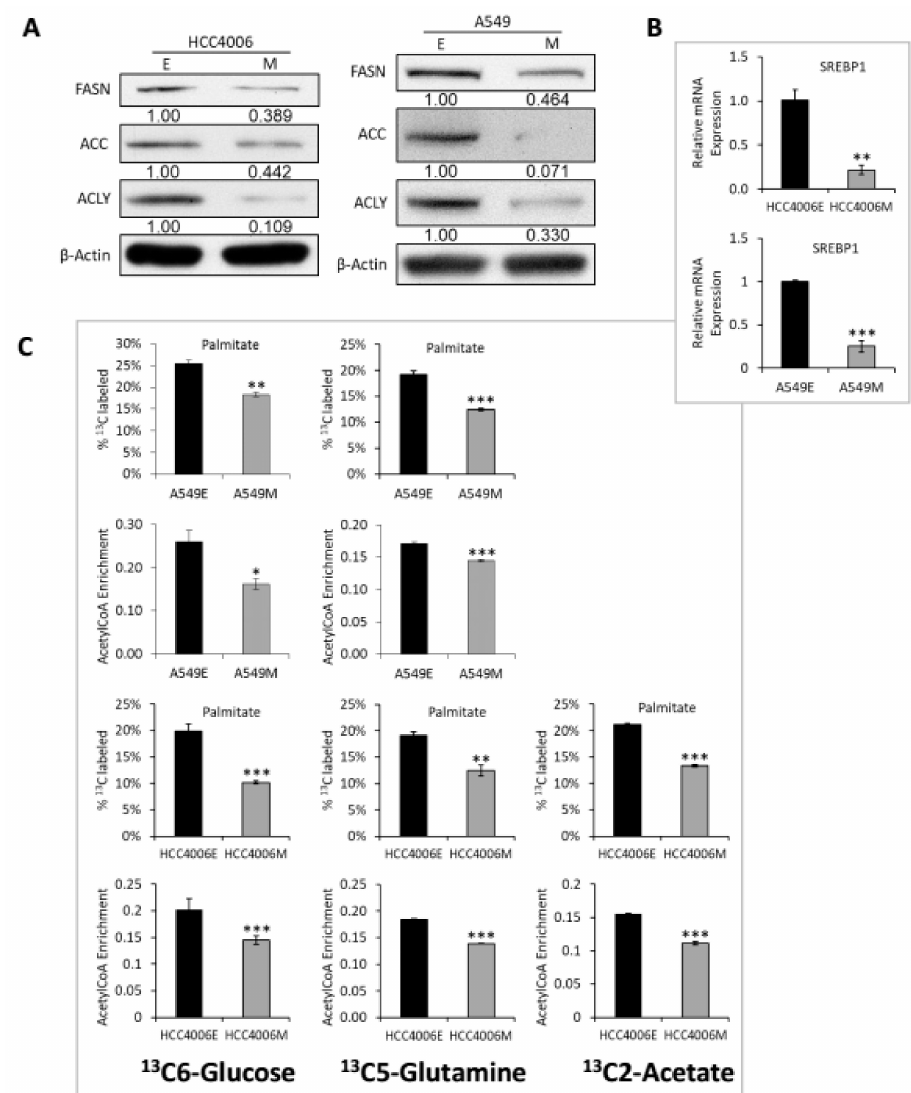
Figure 3. De novo lipid synthesis is decreased in isogenic mesenchymal cell states. ( A ) In HCC4006 and A549 cells, lipogenic enzymes decrease in the M state by immunoblot. ( B ) SREBP1 / SREBF1 RNA is reduced in the M state ( p < 0.05 *; p < 0.01 **; p < 0.001 ***). ( C ) A549 and HCC4006 have decreased incorporation of 13C6-glucose, 13C5-glutamine, and / or 13C2-acetate into palmitate in the M state. They also show decreased acetyl-CoA enrichment by their respective substrates. Isotopologue distributions are shown in Supplementary Figure